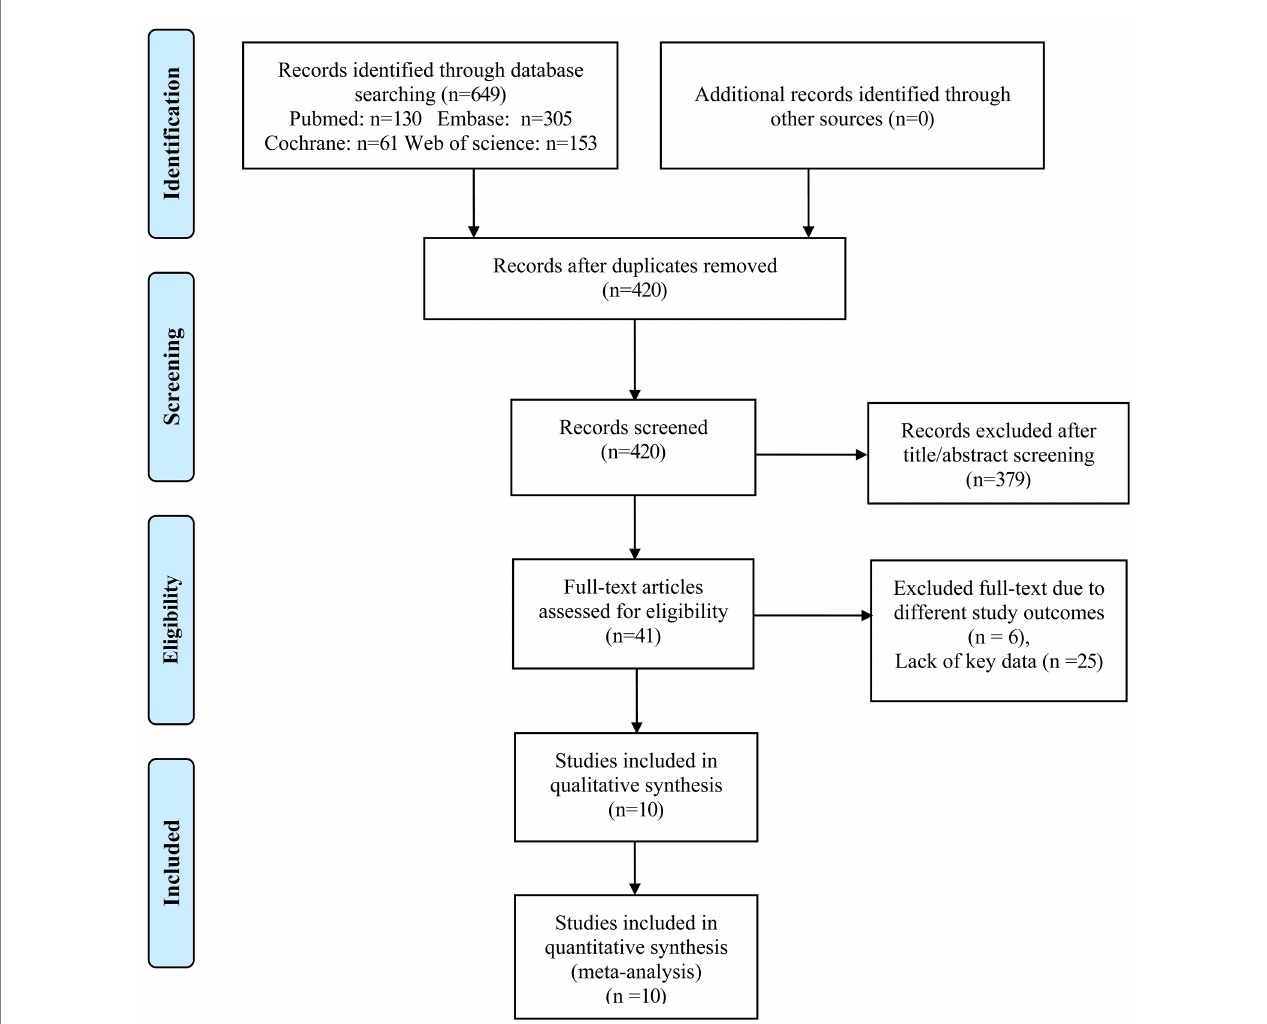
FIGURE 1 Flowchart showing selection of